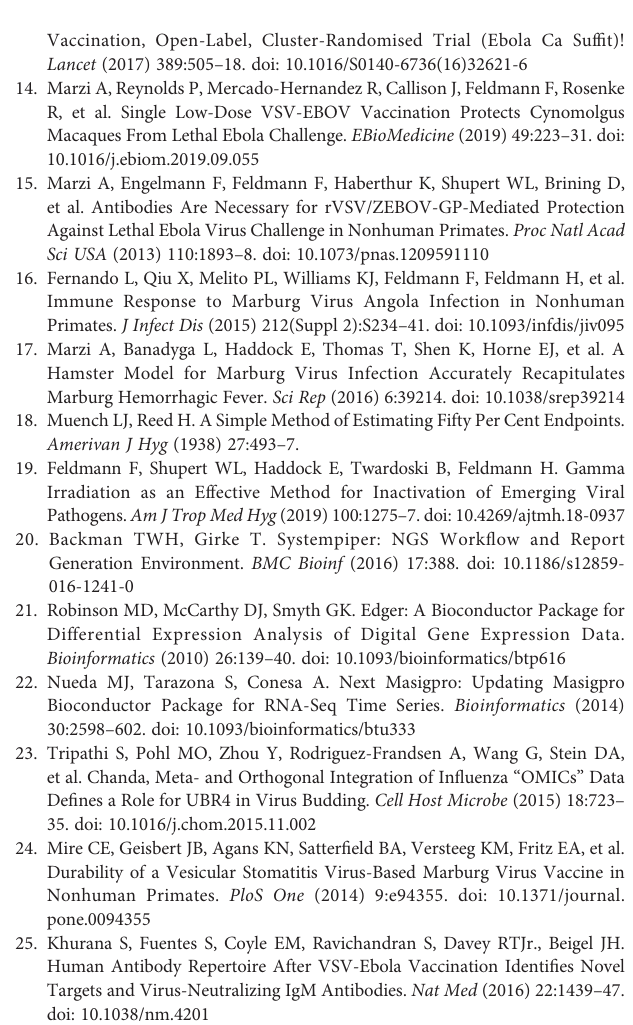
Supplementary Figure 1 | Blood cell counts and serum chemistry of NHPs. Supplementary Figure 2 | Cytokine response in vaccinated and challenged NHPs. Supplementary Figure 3 | Transcriptional changes after